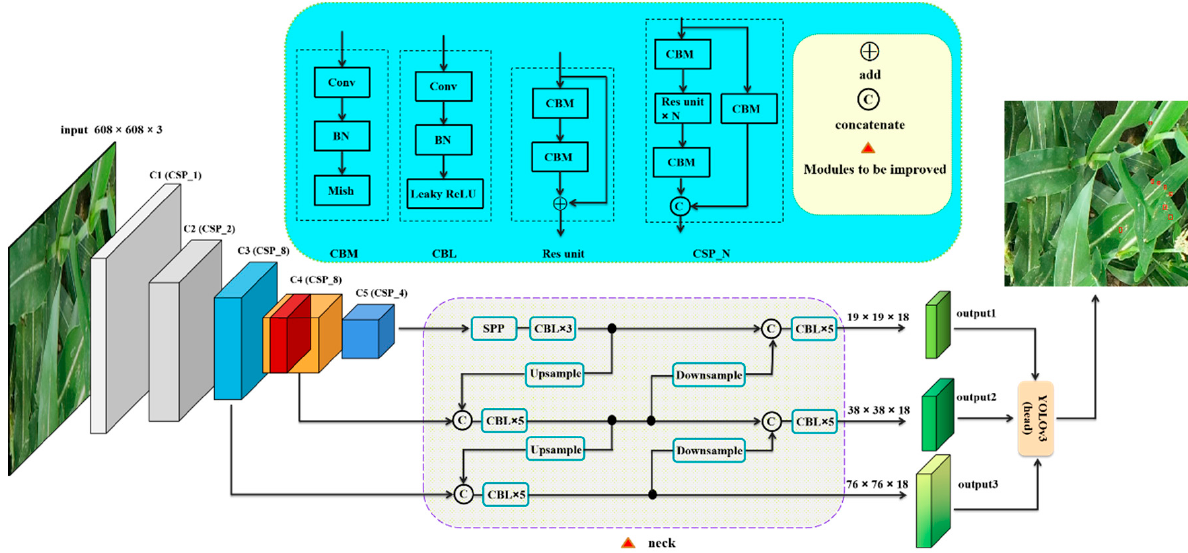
Figure 4. Structure diagram of YOLOv4 model; the red cube represents C4(CSP_1), which is the intermediate feature map output by the first small residual block in the C4 layer.